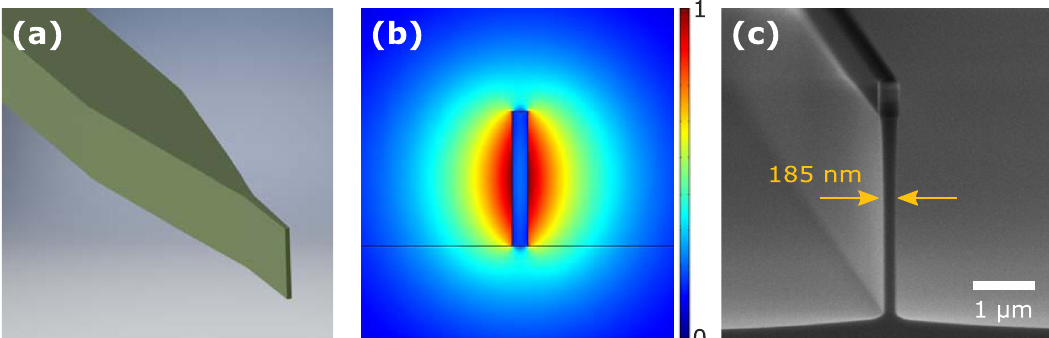
Fig. 3 Design and microscope image of the inverse taper. a Illustration of the inverse taper used to minimize re fl ections at the output facet. b Finite Element Mode (FEM) simulation of the fundamental transverse electric (TE) mode of the inverse taper with 2000 nm height (H) × 200 nm width (W). c Scanning electron microscope (SEM) image of a high-aspect-ratio inverse taper structure similar to the one used in our mid-infrared (mid-IR) laser.